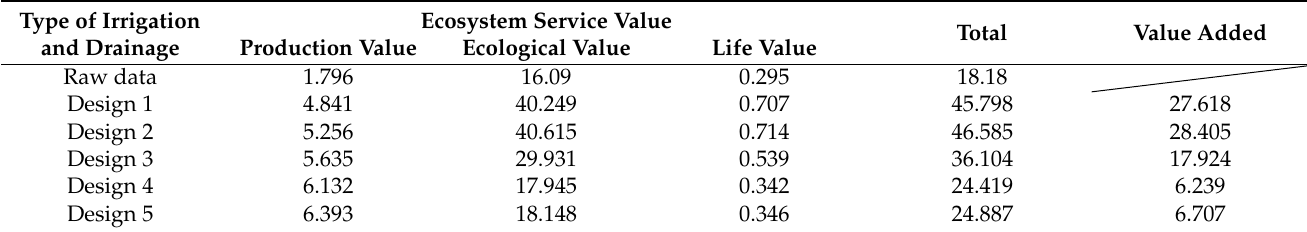
Table 6. Value of ecosystem services under different irrigation and drainage patterns. Unit: RMB10 6 . Type of